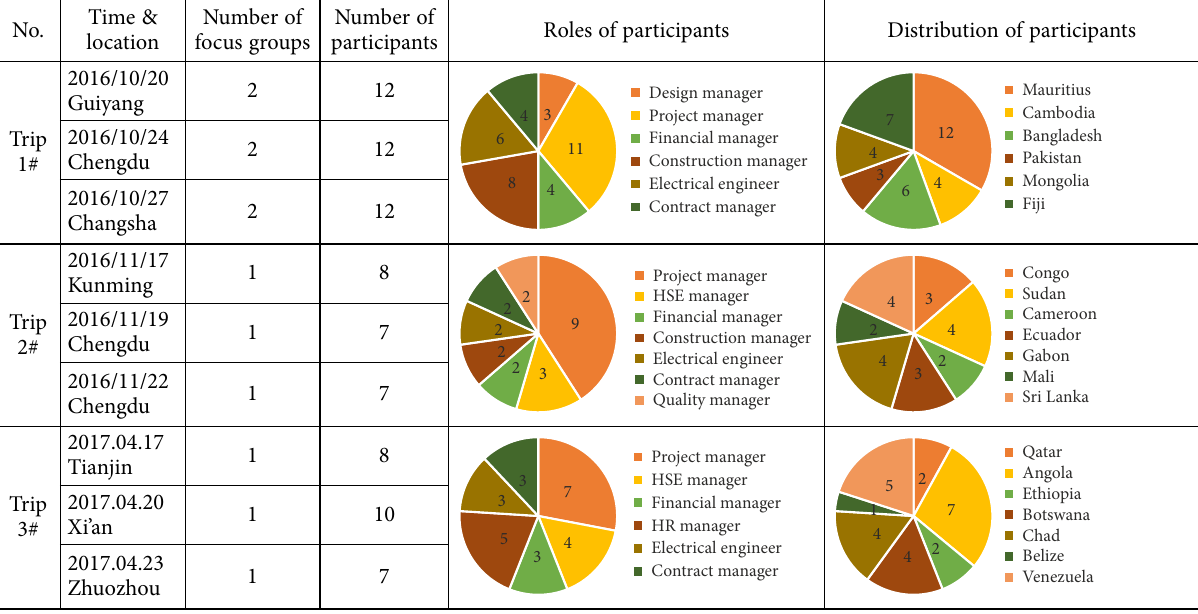
Table 2. Profiles of focus groups and 83